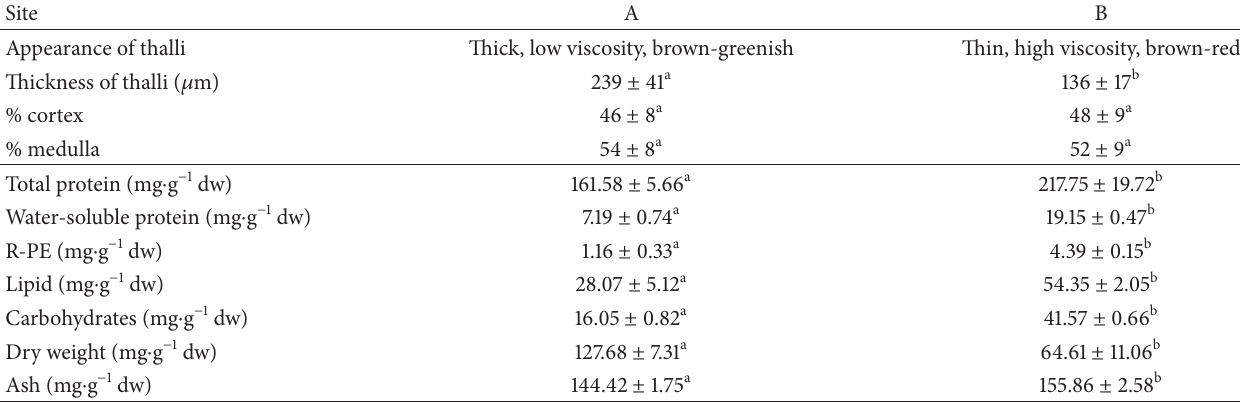
Table 1: Grateloupia turuturu : morphological aspects and biochemical composition of site A and B samples.